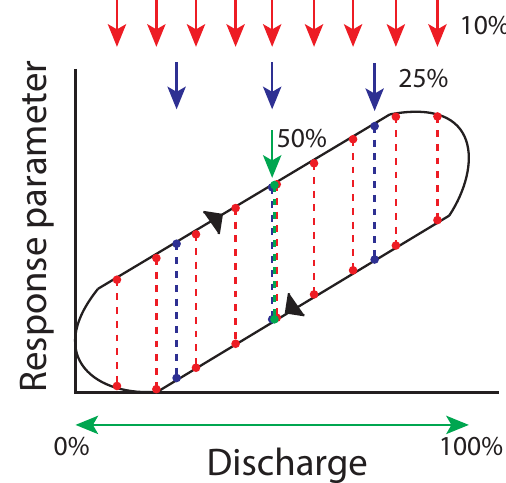
Figure 3. Examples of how the sampling intervals for the calcula- tion of the HI LA and HI new are determined. The coloured arrows and dashed lines illustrate the position of sections used for the cal- culation of the HI, where 50, 25, or 10% intervals are used. The coloured dots show the positions on the rising and falling limbs used to calculate the